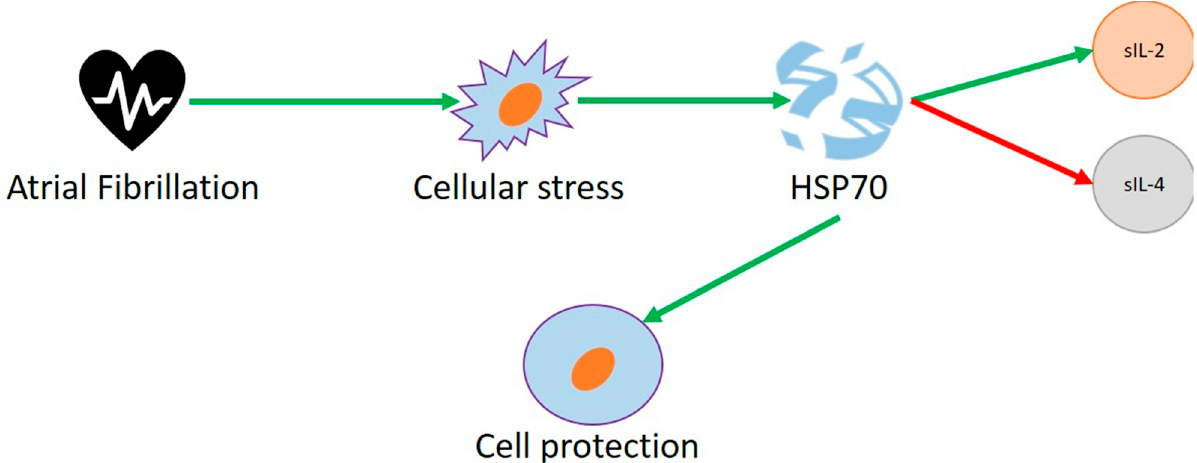
Figure 3. High levels of HSP70 have been shown in patients with atrial fibrillation as a protective antiarrhythmic molecule, correlating with sIL-2 (green arrow) and inversely correlated with sIL-4 concentration (red arrow).